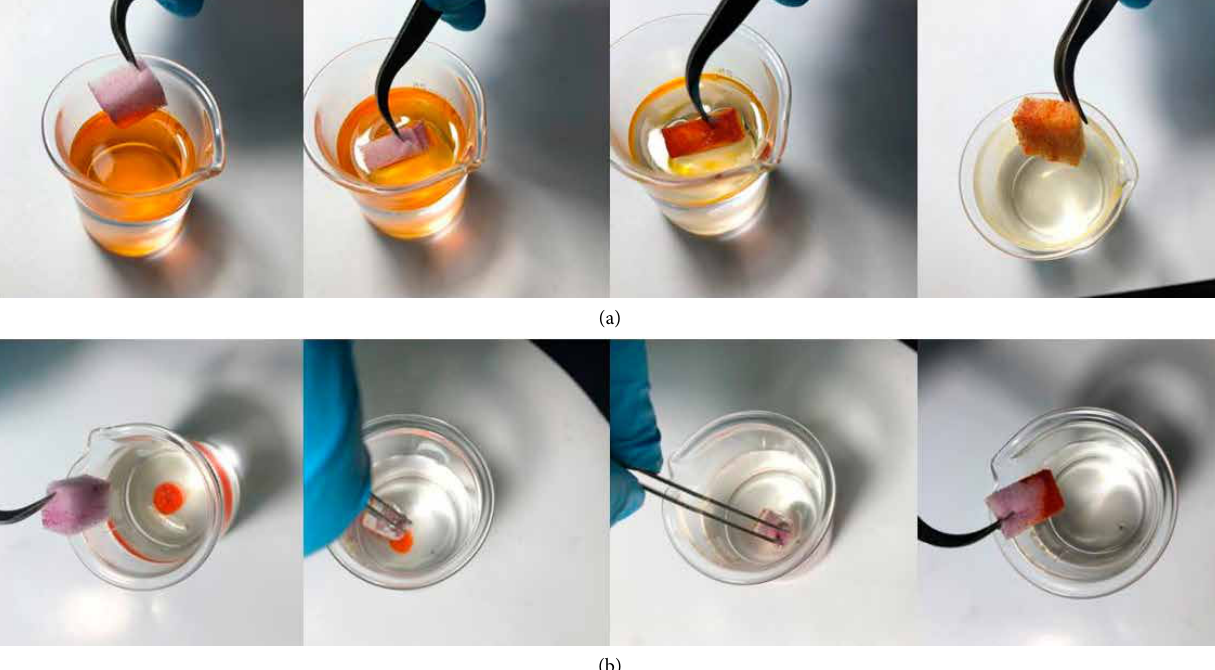
Figure 6: Photographs of the selective sorption of oil with the PDMS-SP coated melamine sponge. The oil was dyed with Sudan I. (a) Hexadecane as oil. (b) Chloroform as